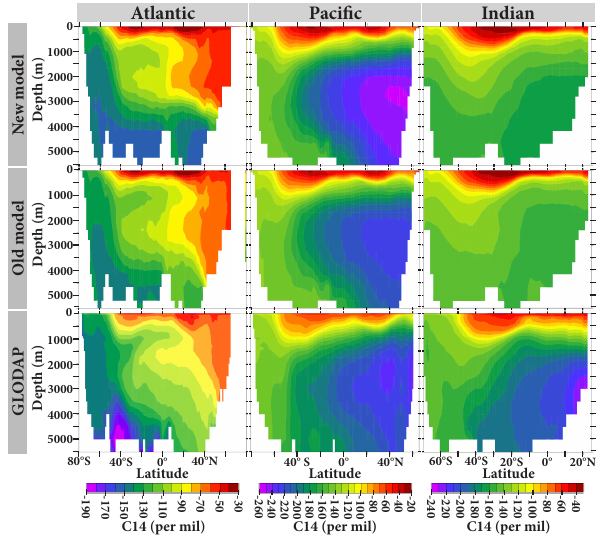
Fig. 8. Zonally averaged ocean basin comparisons of C14 between the new and old models and the GLODAP data set.